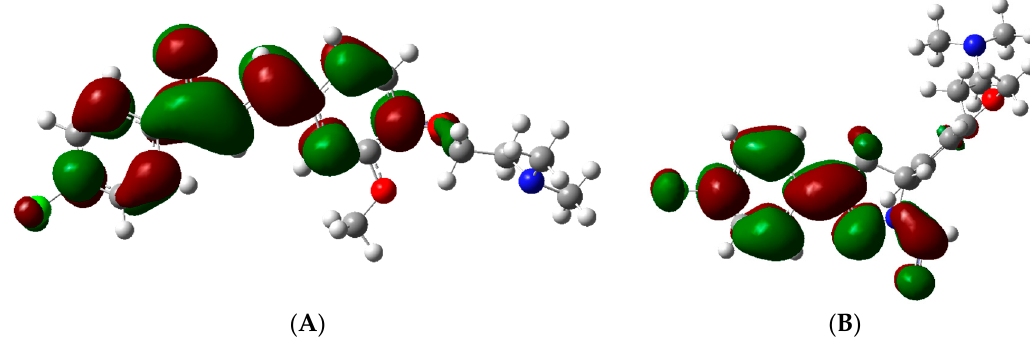
Figure 3. LUMO orbitals for compounds 4a ( A ) and 5a ( B ).